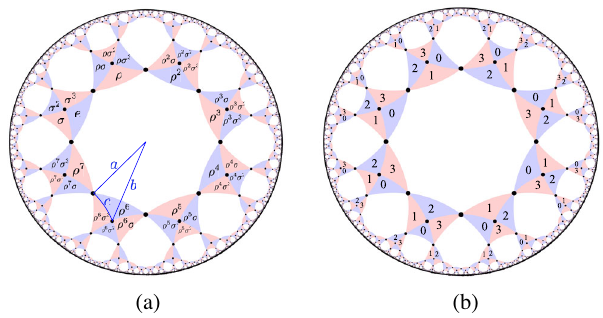
FIG. 26. The f 8 ; 4 g subsystem hyperbolic code. (a) Each triangle operator can be uniquely identified with an element of the proper symmetry group G H þ 8 of the lattice (after identifying a ; 4 triangle operator with the identity element e ). We label a fundamental triangle in blue. (b) Each triangle operator can be labeled with an element of Z 4 using the homomorphism h ð ρ Þ ¼ h ð σ Þ ¼ 1 from G H þ 8 to Z 4 . The neighborhood of each triangle ; 4 operator (the labels and relative locations of triangle operators it overlaps with) is the same as in the toric